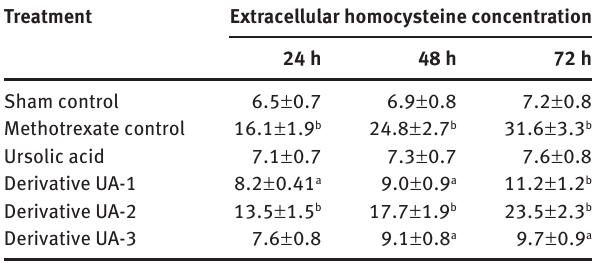
Table 1 Effect of ursolic acid and its novel synthesized derivatives UA-1, UA-2 and UA-3 on extracellular homocysteine concentration in HepG2 cells after 24, 48 and 72 h of incubation.